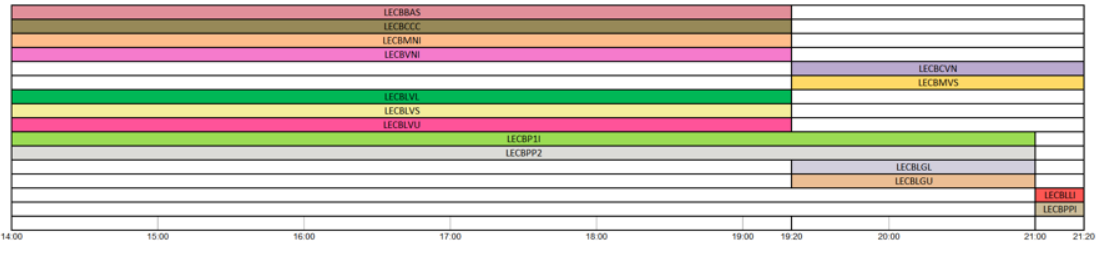
Figure 12. Sectorization of instance 4.